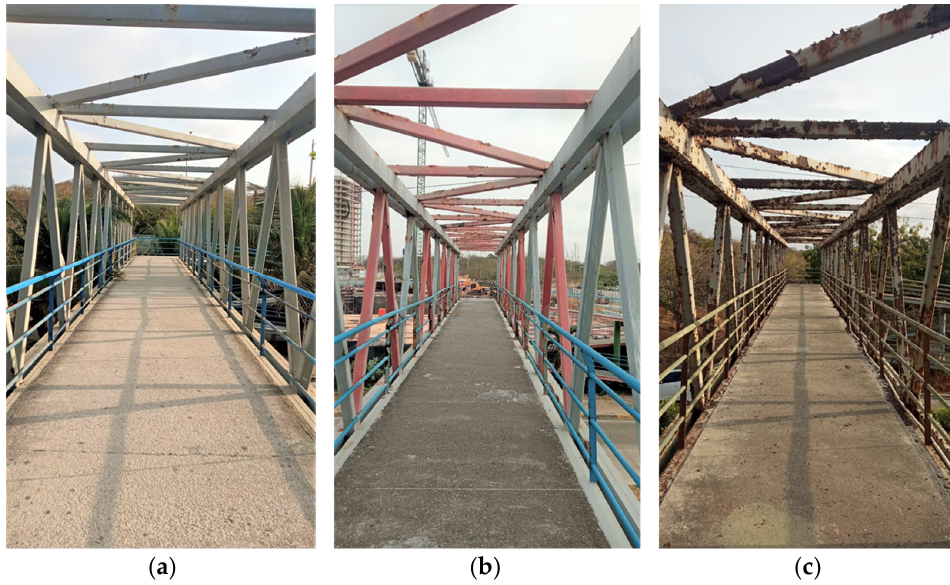
Figure 1. Current status of pedestrian bridges. ( a ) Uninorte, ( b ) Sagrado and, ( c ) Unilibre. The bridges under evaluation are located in Puerto Colombia, Colombia, approxi- mately 3.5 km from the Caribbean Sea (Figure 2a). The conditions at this location promote accelerated corrosion of the elements. The structures under study are similar in geometry, materials, and structural configuration, but differ significantly in their degree of deterioration and functionality (Figure 1). The difference in their degree of deterioration was caused by the different maintenance made by private institutions located nearby the bridges. Therefore, the question to solve is how the degree of corrosion of a pedestrian bridge affects the dynamic behavior of the structure. The bridges have been named after the educational institution next to them, and therefore, in this document, they will be referred to as “Uninorte” (Universidad del Norte), “Sagrado” (Sagrado Coraz ó n School), and “Unilibre” (Universidad Libre). The linear distance between the Sagrado bridge and the Uninorte bridge is approximately 690 m, and the distance between the Uninorte bridge and the Unilibre bridge is approximately 1600 m, which indicates that the level of exposure to the marine environment is similar in the three bridges since the three structures are in a radius parallel to the spot described as Mallorquín swamp (lagoon) border Figure 2b.